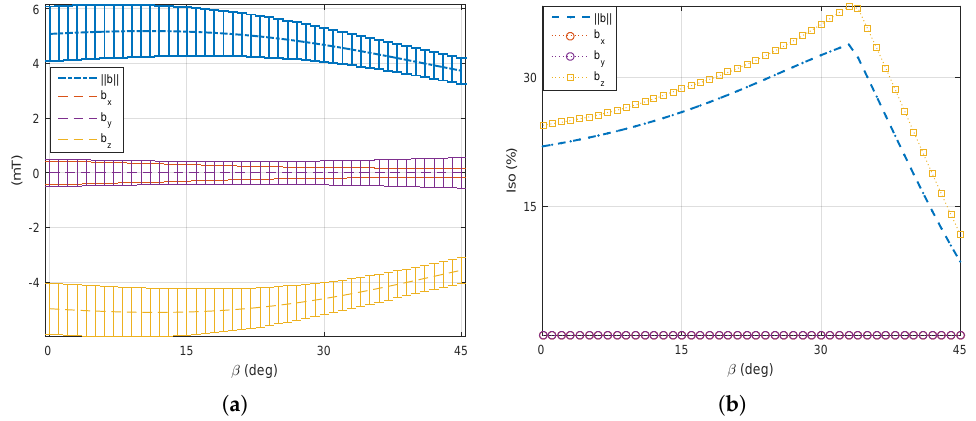
Figure 21. Two mobile electromagnets (dual coils 5 and 7) are rotating and the other coils set to β = 33°: ( a ) the average and ( b ) the uniformity of the magnetic field.